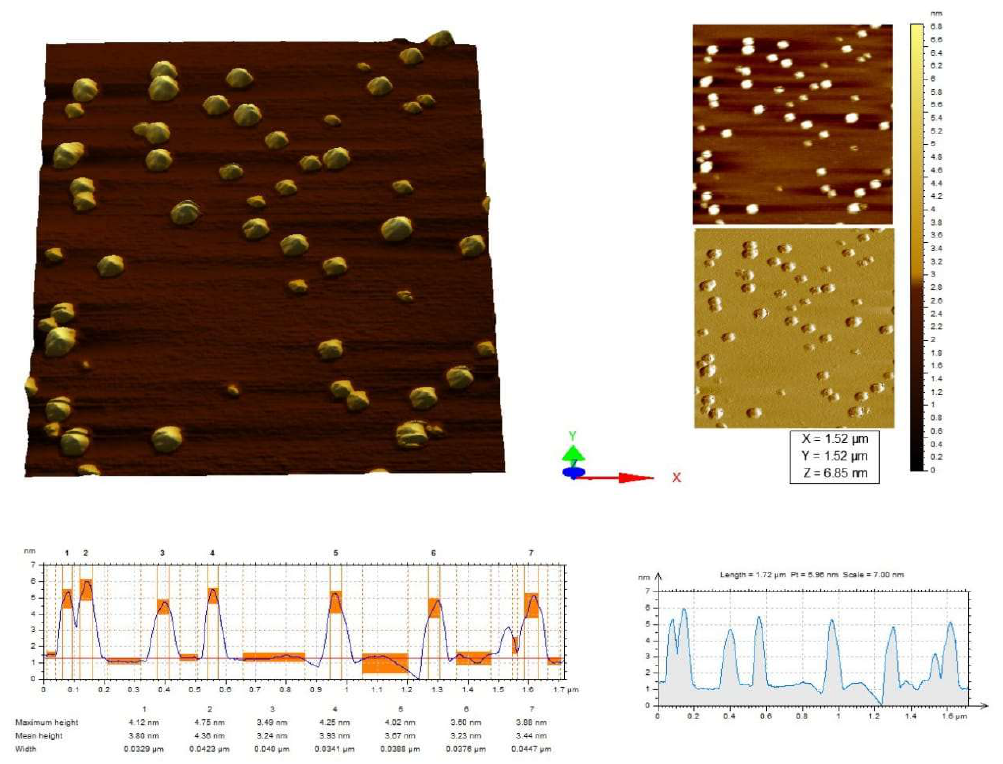
Figure 5. AFM images (2D and 3D) of Pantoea stewartii -synthesized Ag NPs.